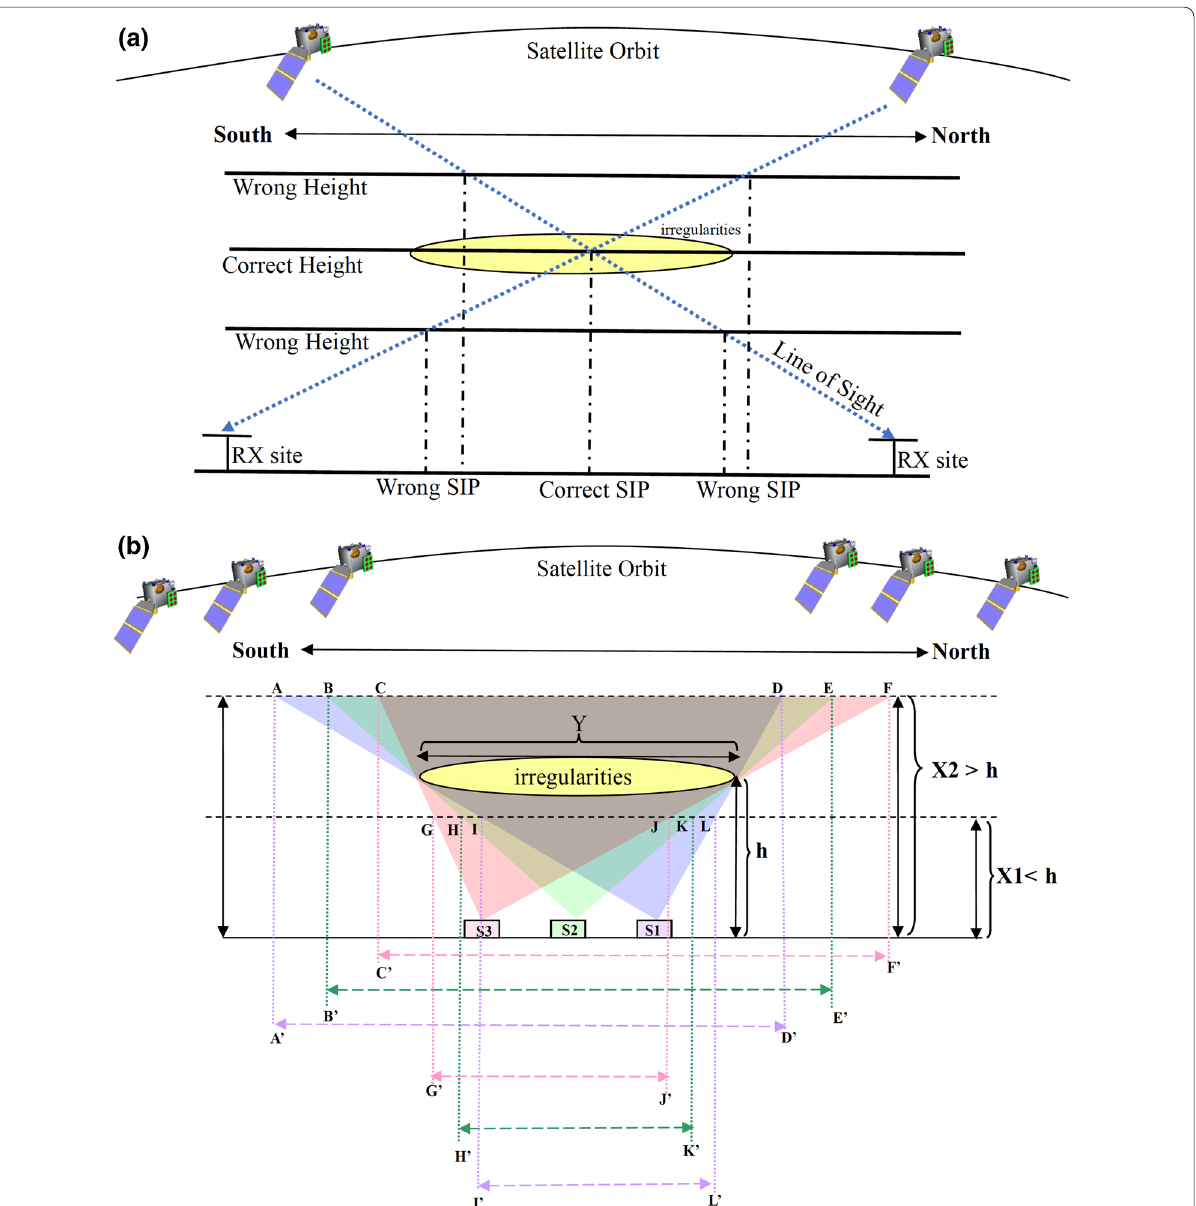
Fig. 2 a Two SIPs (sub‑ionosphere point) from one satellite pass project different position of irregularities if the assumed height is wrong. b North–south view of the project method. By changing the height of the penetration points, it will cause the movements of the projection line. The projection lines remain the same if the correct height of the penetration points is